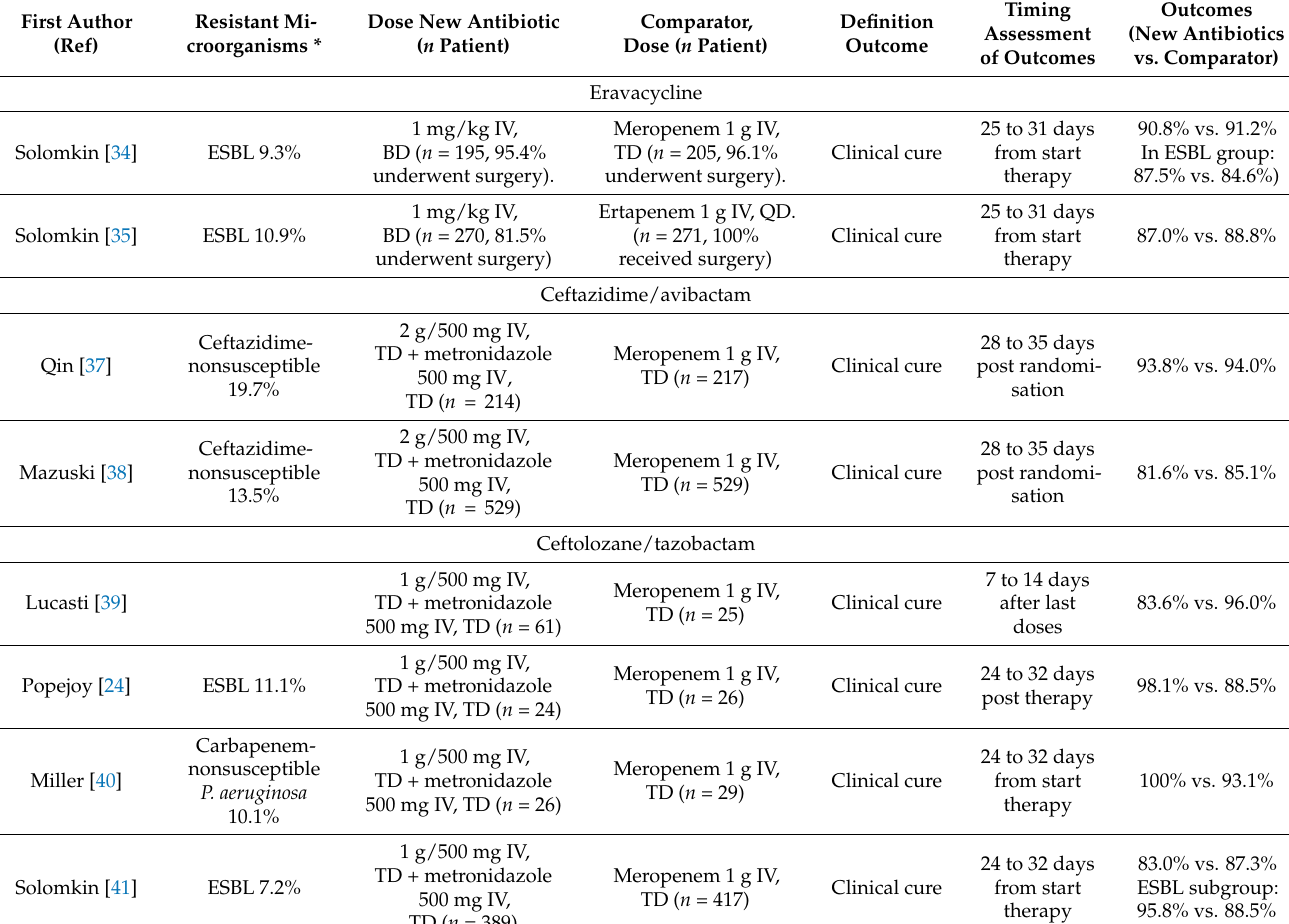
Table 2. Clinical trials on complicated intra-abdominal